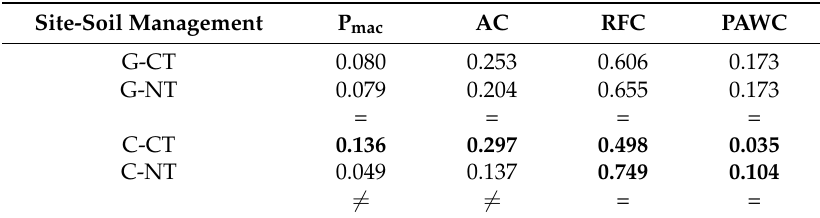
Table 6. Mean values of capacity-based indicators measured at Gravina (G) and Candela (C) sites under conventional tillage (CT) and no-tillage